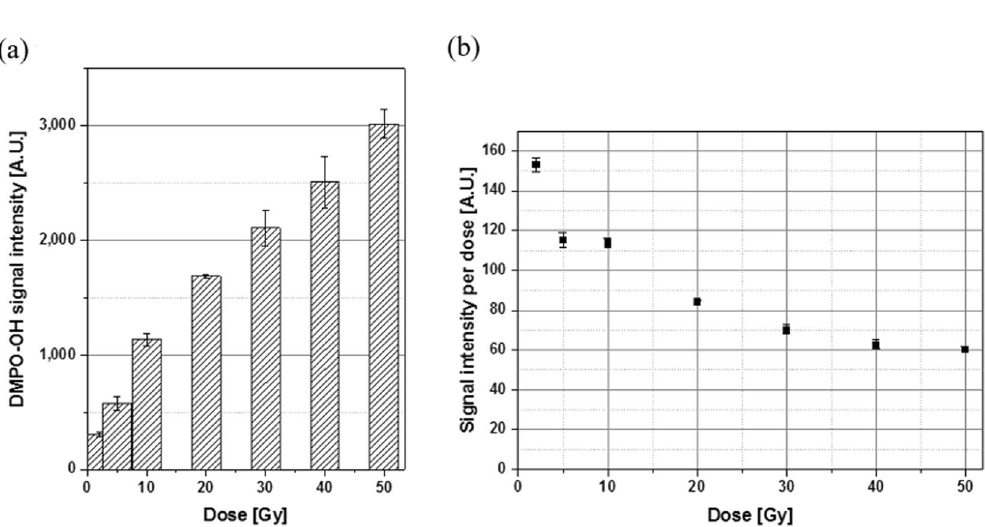
Figure 2. Average of the second and third peaks’ DMPO-OH signal intensities in an arbitrary unit measured at 6 min after 2–50 Gy of radiation exposures: ( a ) total intensity and ( b ) intensity per unit dose. Each error bar indicates one standard error of the mean obtained from three independent